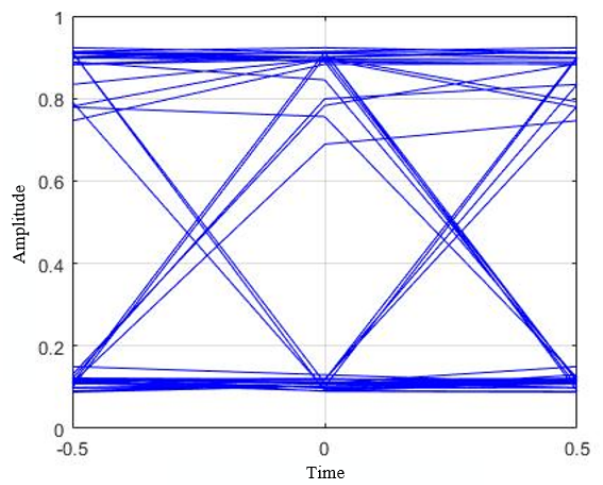
Figure 12. Eye diagram of SVM assisted intelligent OCC receiver while exposure time ( T e ) is 977.6 µ s.